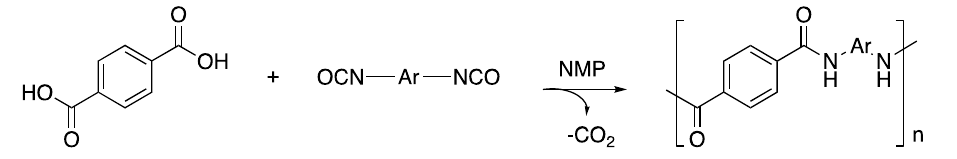
Figure 1. General scheme for polyamide synthesis.